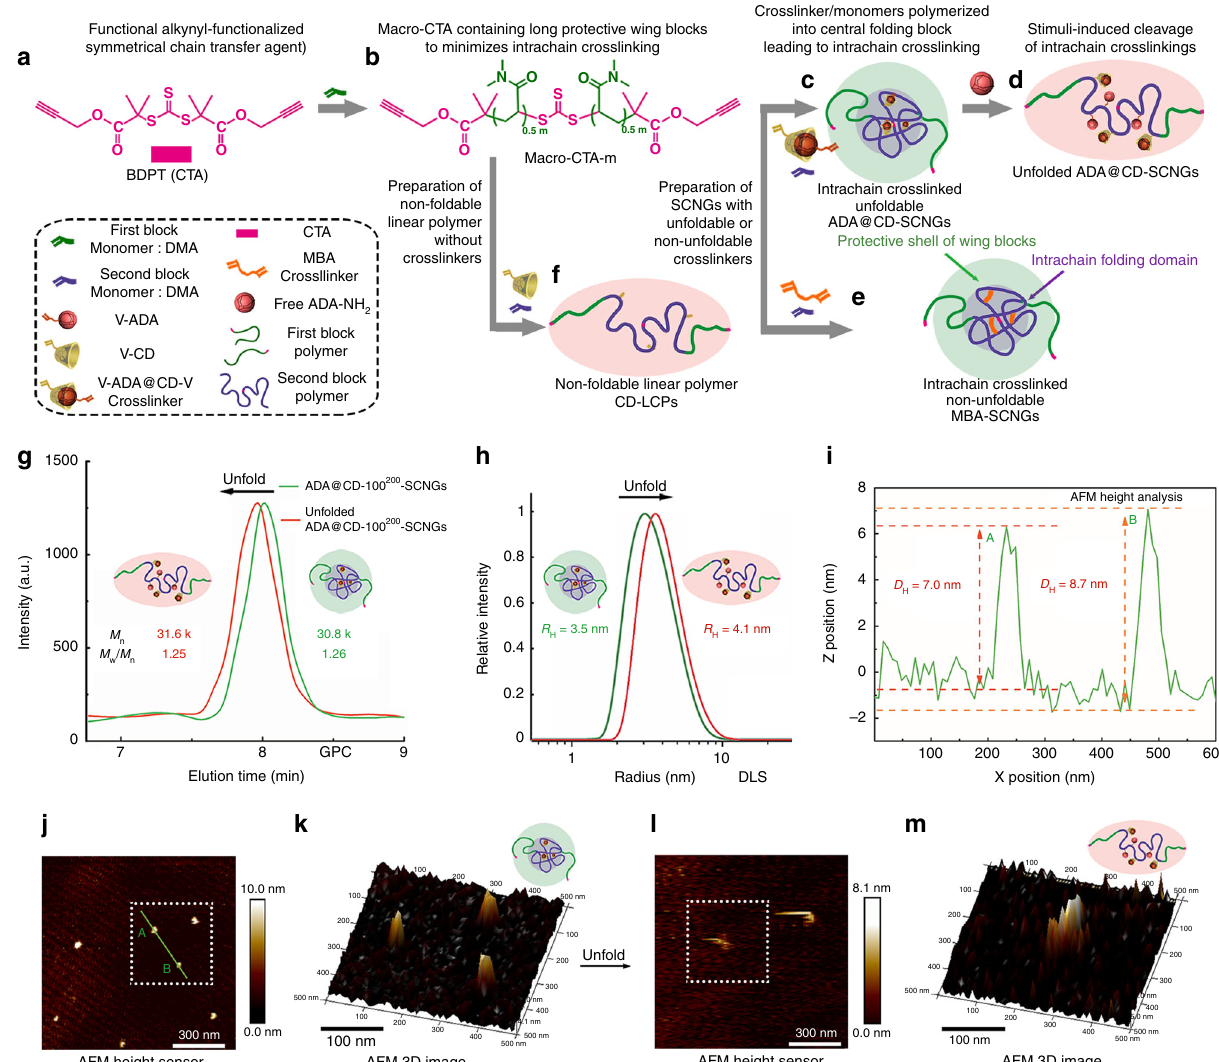
Fig. 1 Preparation and characterization of the supramolecular SCNGs at high concentrations. a , b The preparation scheme of the c unfoldable dynamic ADA@CD-SCNGs, d unfolding process of the ADA@CD-SCNGs, e non-unfoldable SCNGs and f non-foldable linear polymer. g GPC traces for the ADA@CD crosslinked unfoldable ADA@CD-SCNGs (green line) and the corresponding unfolded species (orange line) after treating the SCNGs with free competitive ADA. The unfolding of the ADA@CD-SCNGs led to a slight increase in the apparent molecular weight. h DLS analysis of the folded (green line) and unfolded ADA@CD-SCNGs (orange line). i Atomic force microscopy (AFM) height analysis of two-folded ADA@CD-SCNG particles A and B shown in panel j . j AFM height image of the ADA@CD-SCNGs and l the unfolded species. k 3D modelling image of the ADA@CD-SCNGs and m the unfolded species on silica. The length scale bars of j and l are 300.0 nm, of k and m are 100.0 nm. The height colour scale of j and k is from 0 to 10 nm by height, the colour scale of l and m is from 0 to 8.1 nm by